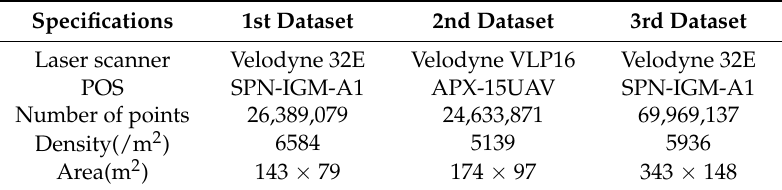
Table 2. Specifications of three datasets used in the paper.